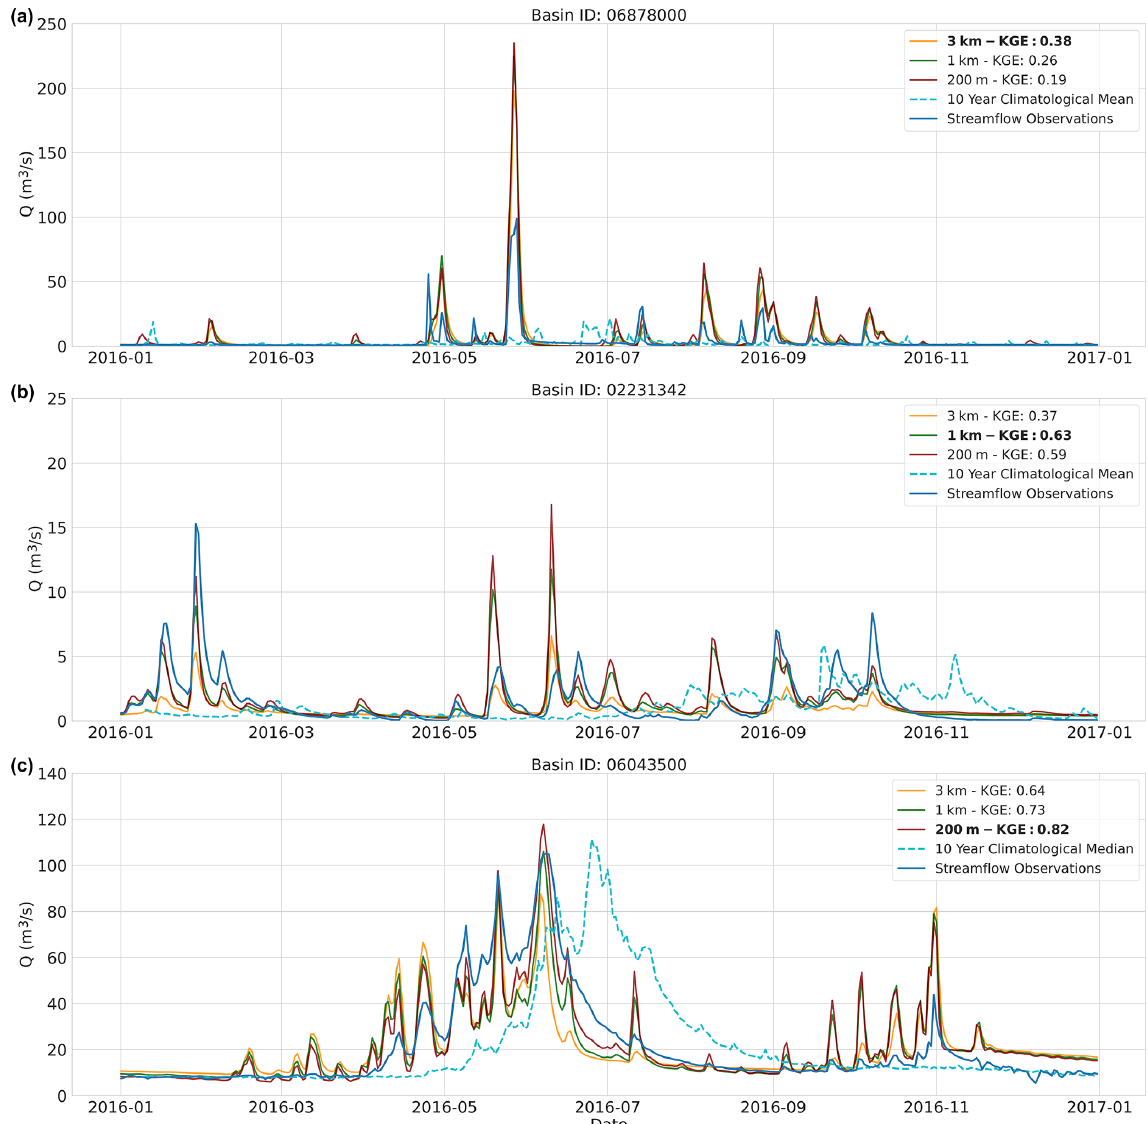
Figure 7. Evaluation period results. Three example hydrographs showing the last year of the evaluation period. The 3km (orange), 1km (red), and 200m (green) model instance streamflow estimates at the basin outlet are shown. The streamflow observations are shown in blue and the 10-year calendar-day climatology of the statistical benchmark is shown in dotted cyan. (a) Basin ID: 06878000. (b) Basin ID: 02231342. (c) Basin ID: